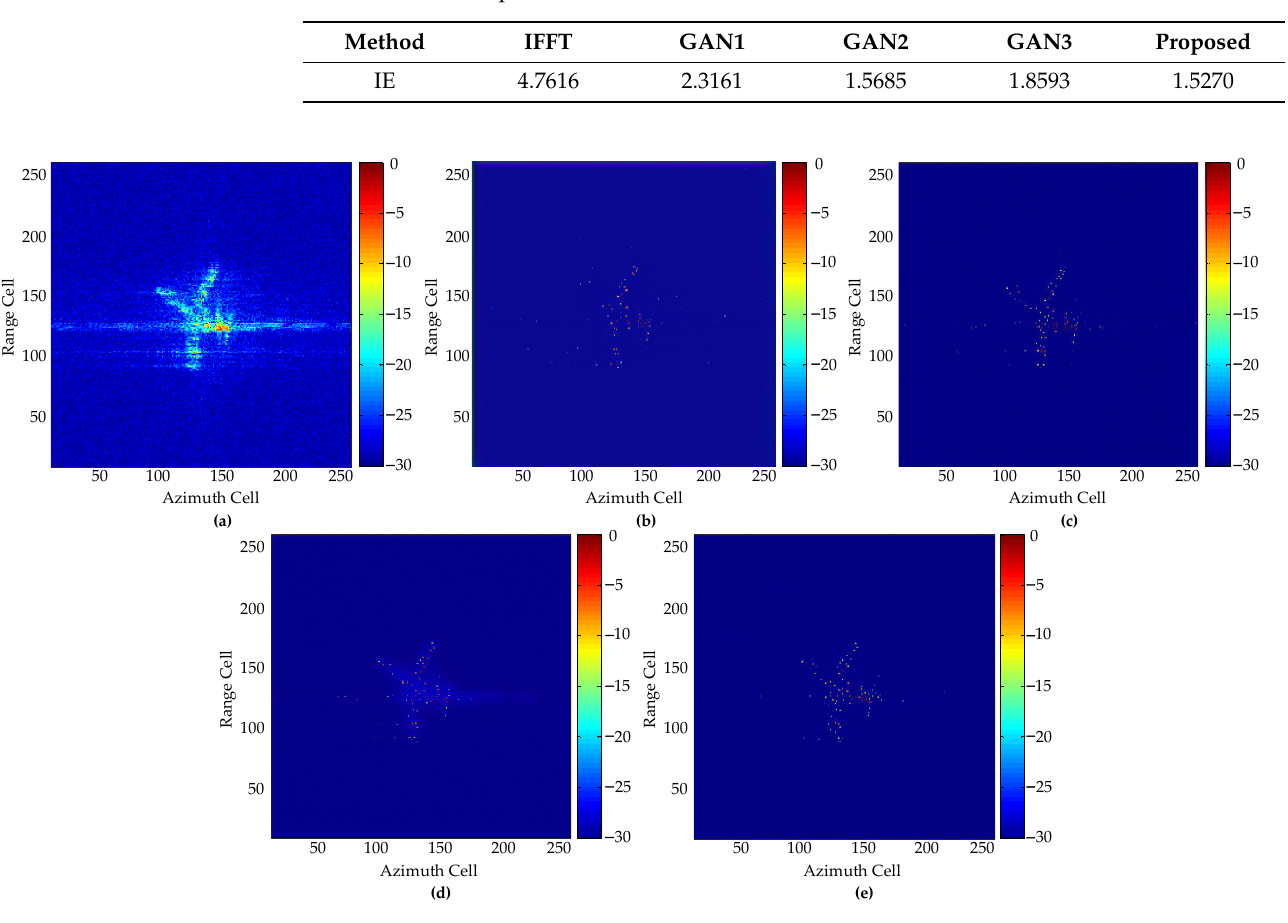
Figure 10. Imaging results of Yak42 at SNR = − 4 dB: ( a ) IFFT; ( b ) GAN1; ( c ) GAN2; ( d ) GAN3; ( e ) Proposed GAN.